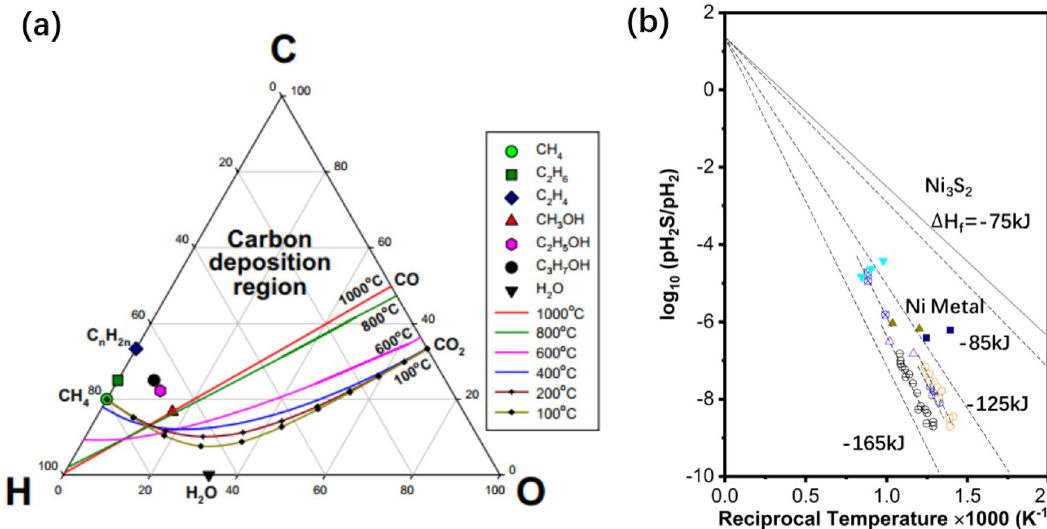
Δ sulfur system (values of Hf based on 1 mol H2S); open symbols for coverage from 0.5 to 0.6 and solid symbols for coverage from 0.8 to 0.9. Reproduced with permission [24]. Copyright 1982,